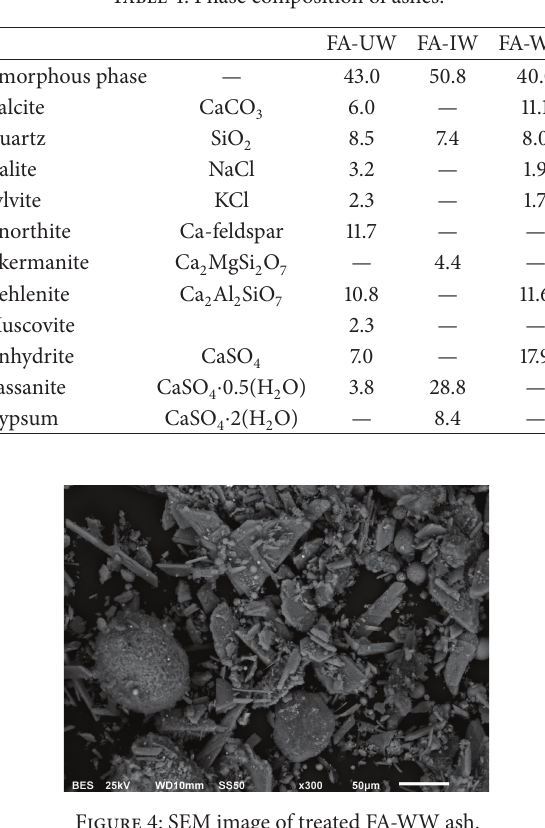
Table 4: Phase composition of ashes.